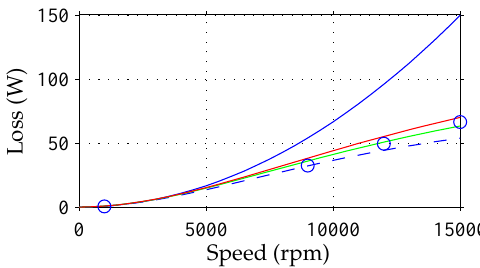
Figure 7. Predicted losses per magnet segment P m as a function of rotor speed and for magnet lengths l m = 60 mm in V-shaped interior PMs ( w m = 30 mm) for Model A (blue lines), Model A, but compensated as P m / ( ε A B + 1 ) (dashed blue line), Model B (red line), Model C (green line), and corresponding 3D-FEM results (circles “ ").